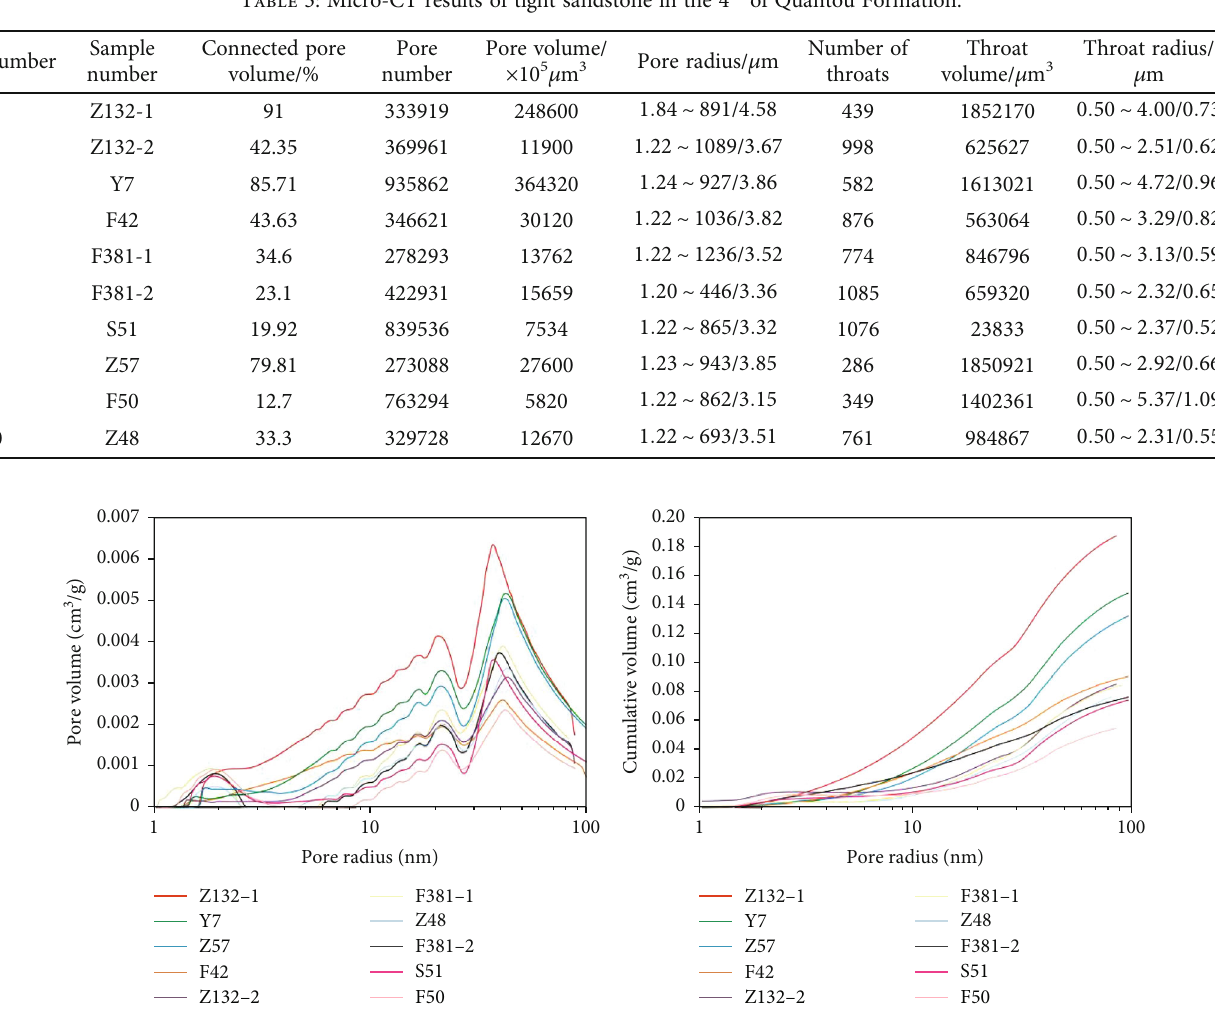
Figure 5: Tight oil pore distribution and cumulative pore radius distribution.